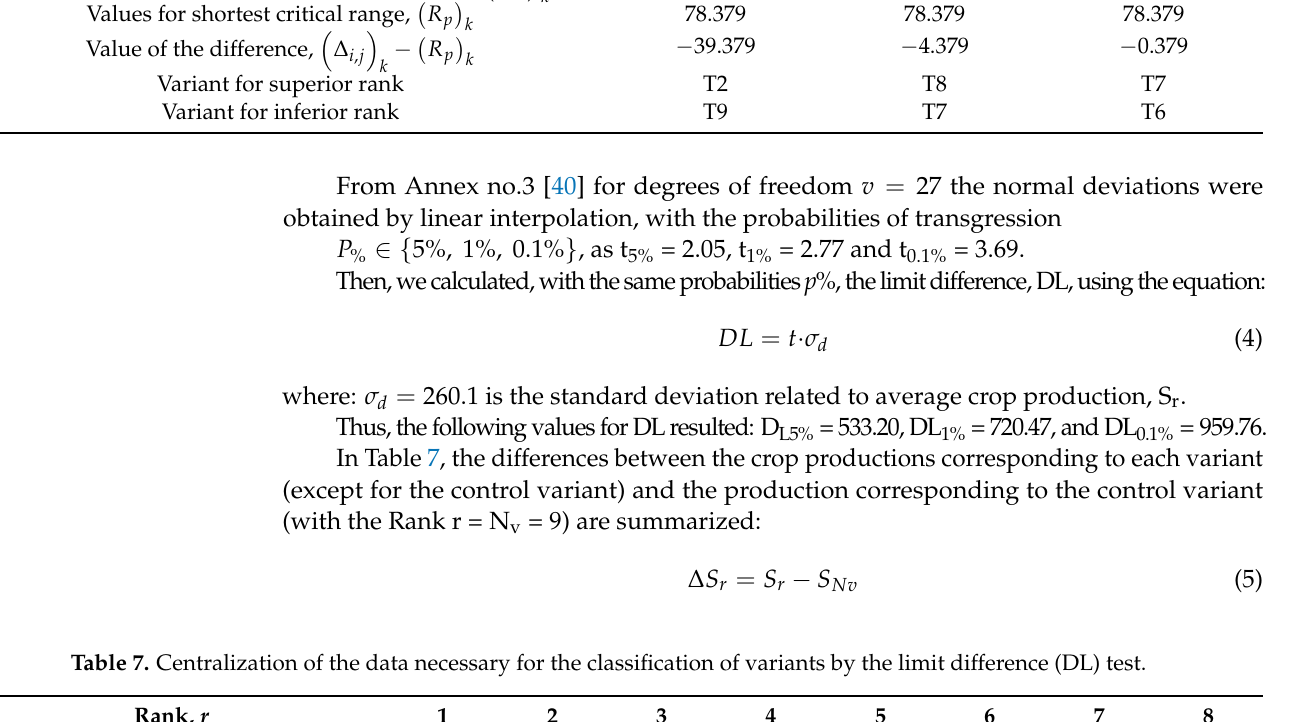
Table 6. Values for the sizes and Difference between Pairs of Variants, k 26 33 35 Values for difference between pairs of variants, Values for shortest critical range,